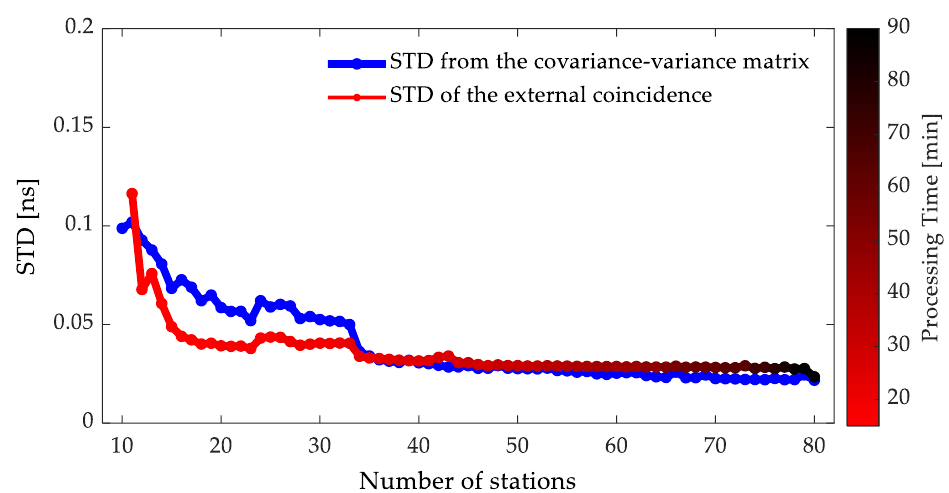
Figure 1. STD and processing time with a gradually increasing number of stations for one week.